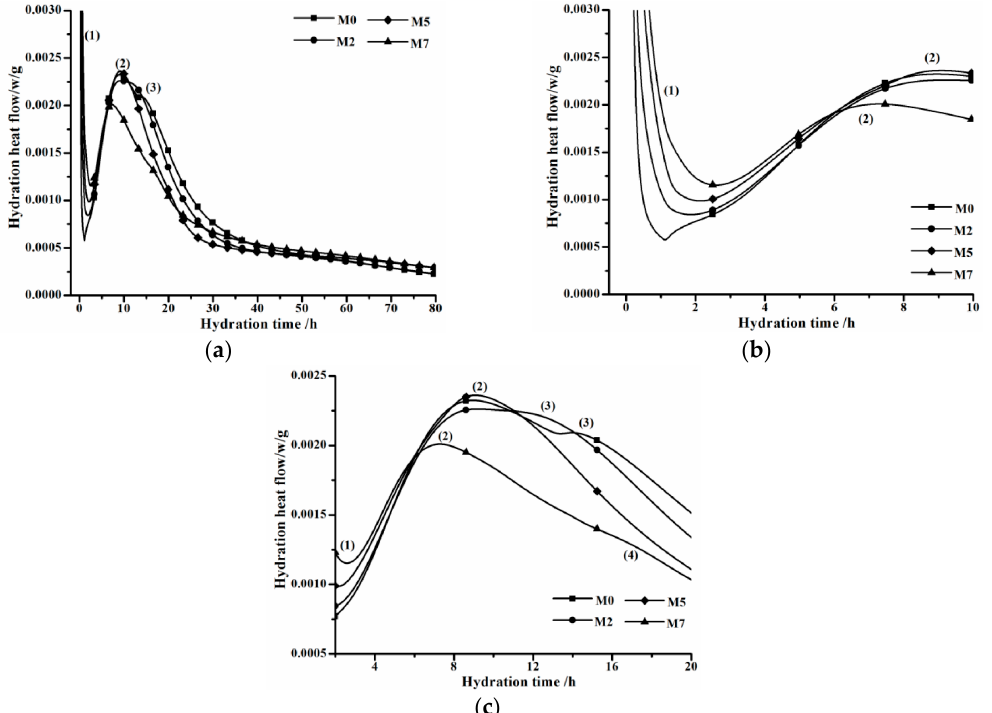
Figure 4. Hydration heat flow curves of samples with various C 12 A 7 replacements plotted in different hydration time ranges. ( a ) in the rage from 0 to 80 h; ( b ) in the range from 0 to 10 h; ( c ) in the range from 2 to 20 h.